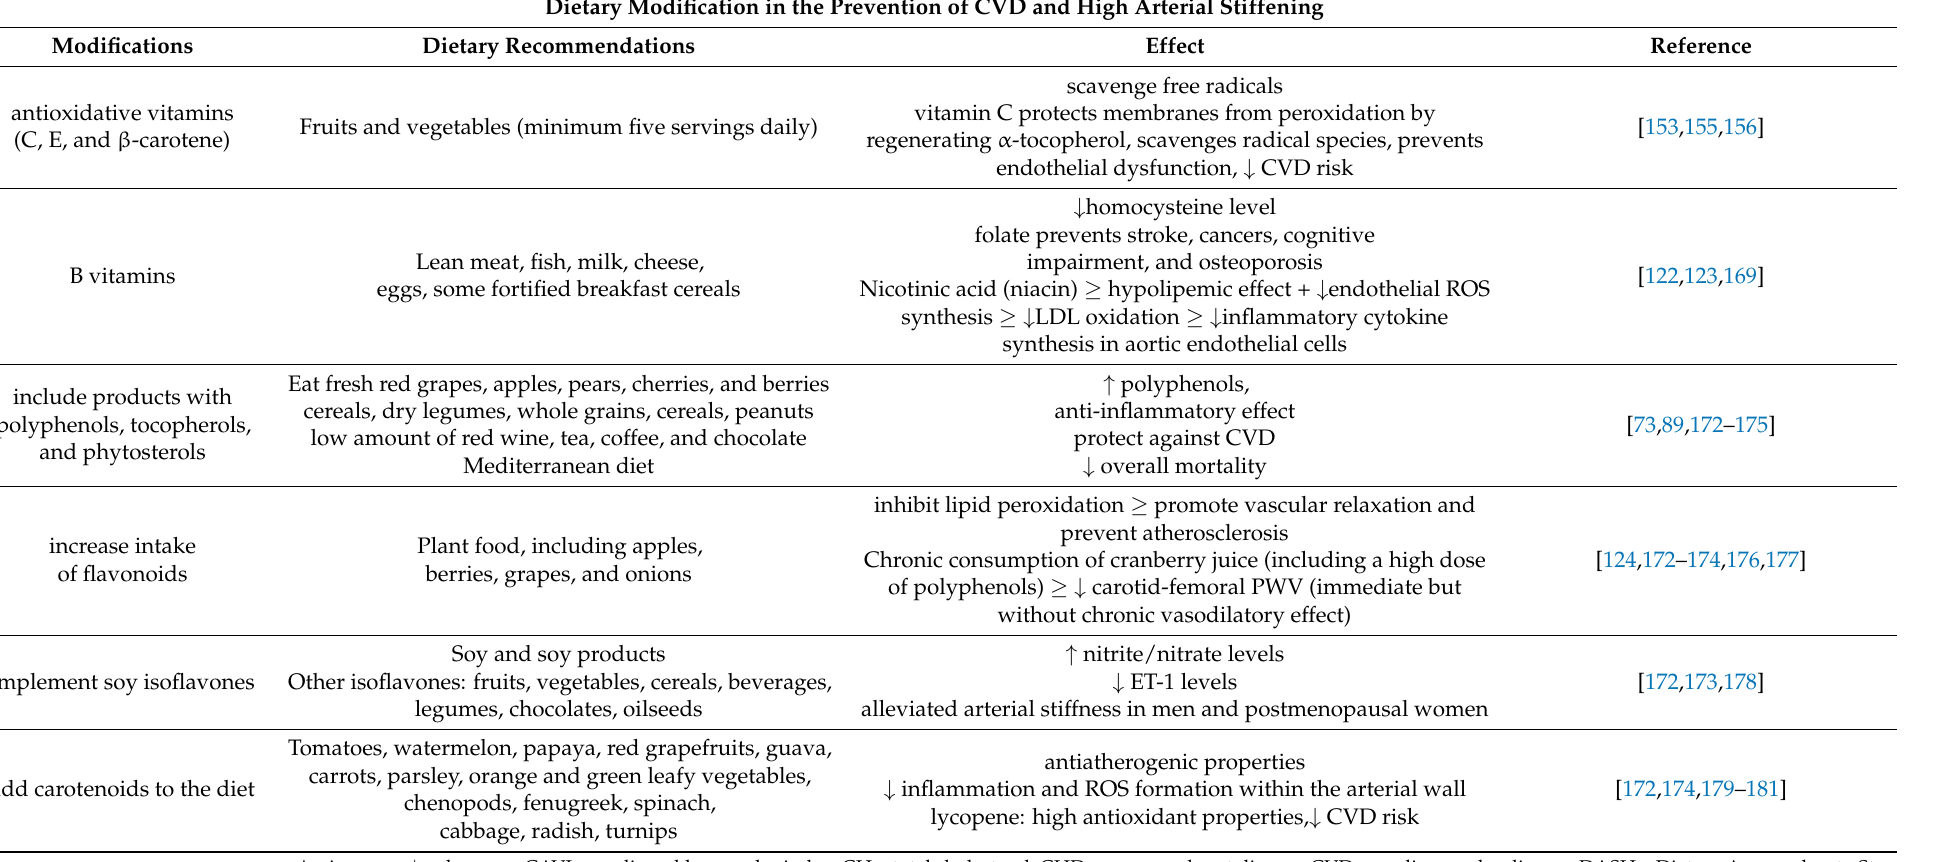
Table 2. Cont. Dietary Modification in the Prevention of CVD and High Arterial